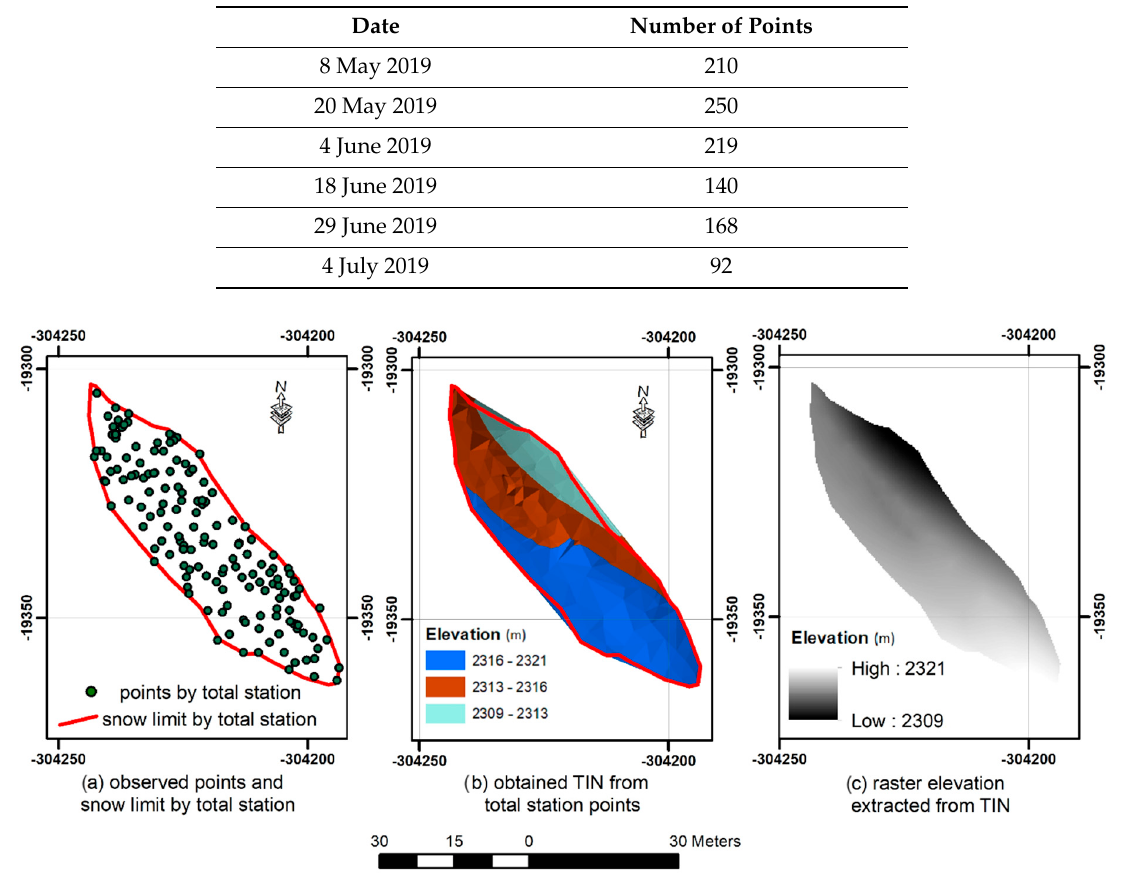
Table 2. Number of points measured by the total station for each surveyed day.